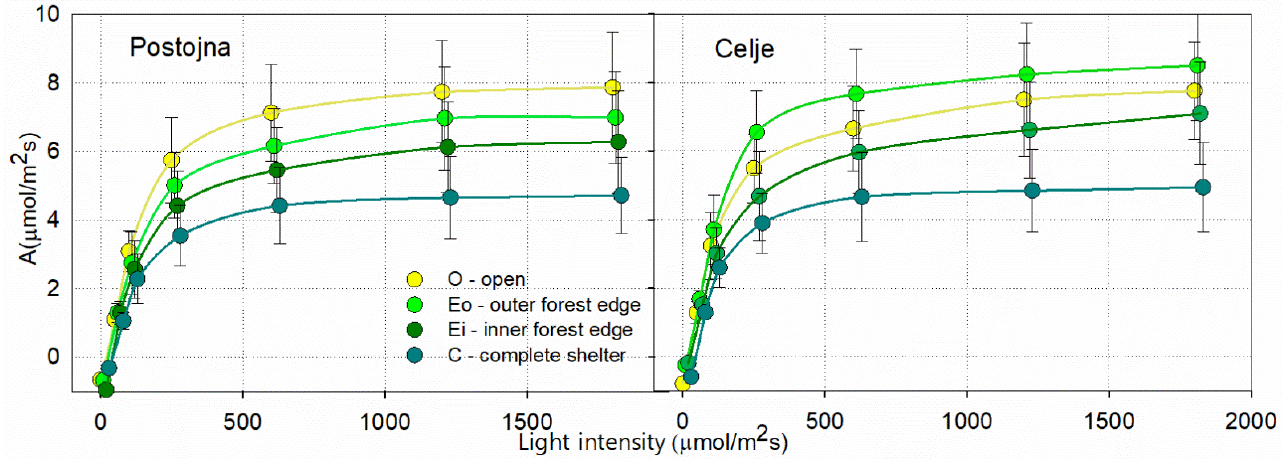
Figure 6. The assimilation rate (A) as a function of light intensity at the Celje ( left ) and Postojna ( right ) sites. Values shown are shifted to avoid overlap and refer to the same light intensity. The bars are standard errors.